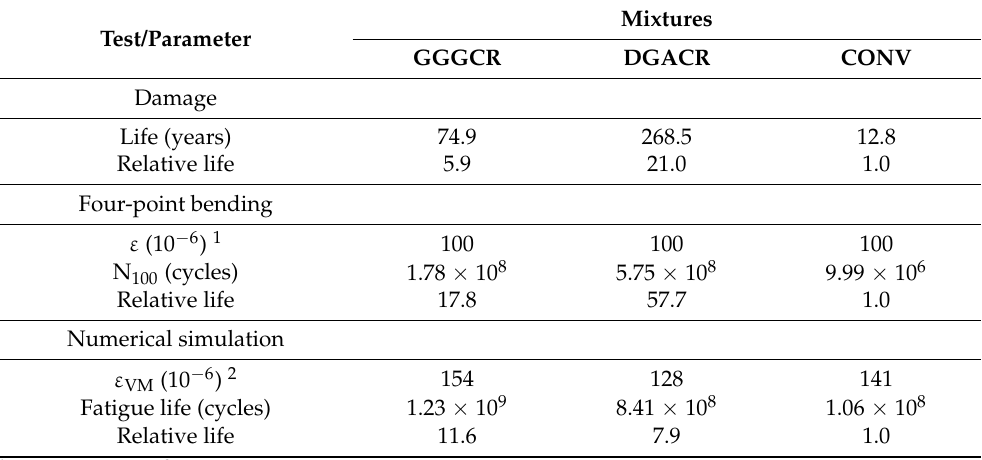
Table 10. Summary of the results of the tests.